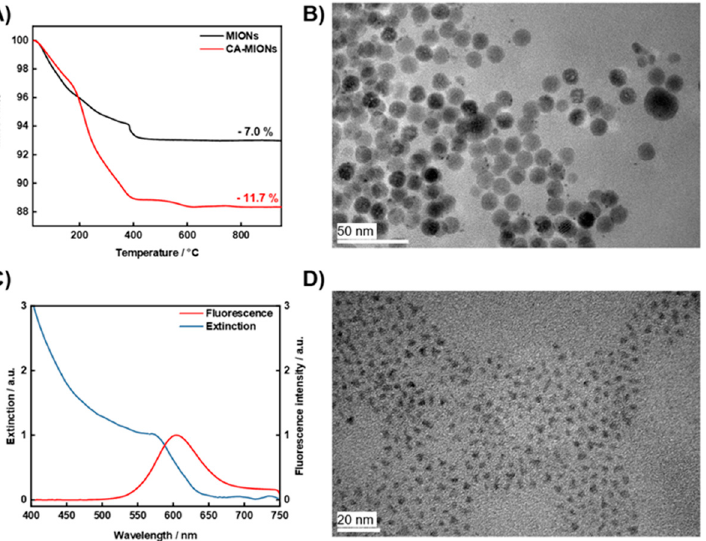
Figure 1. TGA curves of MIONs and CA-MIONs ( A ), TEM images of CA-MIONs and InP/ZnS QDs ( B , D ), and the fluorescence and absorption spectra of InP/ZnS QDs ( C ).